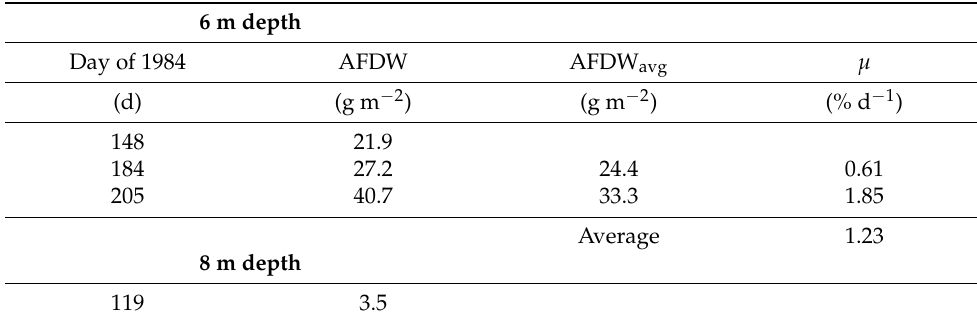
Table A3. Halichondria panicea. Development of biomass (AFDW) in natural sponge populations at Boknis Eck, Western Baltic Sea, at 3 different water depths of 6, 8 and 10 m obtained by replotting data from [35]. Day zero = 1 January